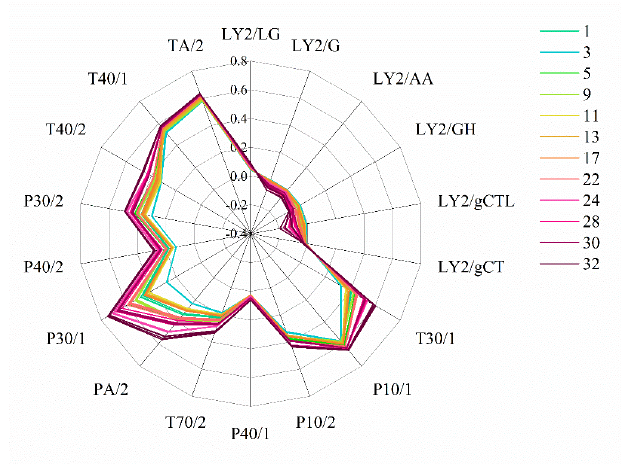
Figure 3. Changes in the response of 18 sensors of the electronic nose to pork samples stored at 4 °C (day 1, 3, 5, 9, 11, 13, 17, 22, 24, 28, 30 and